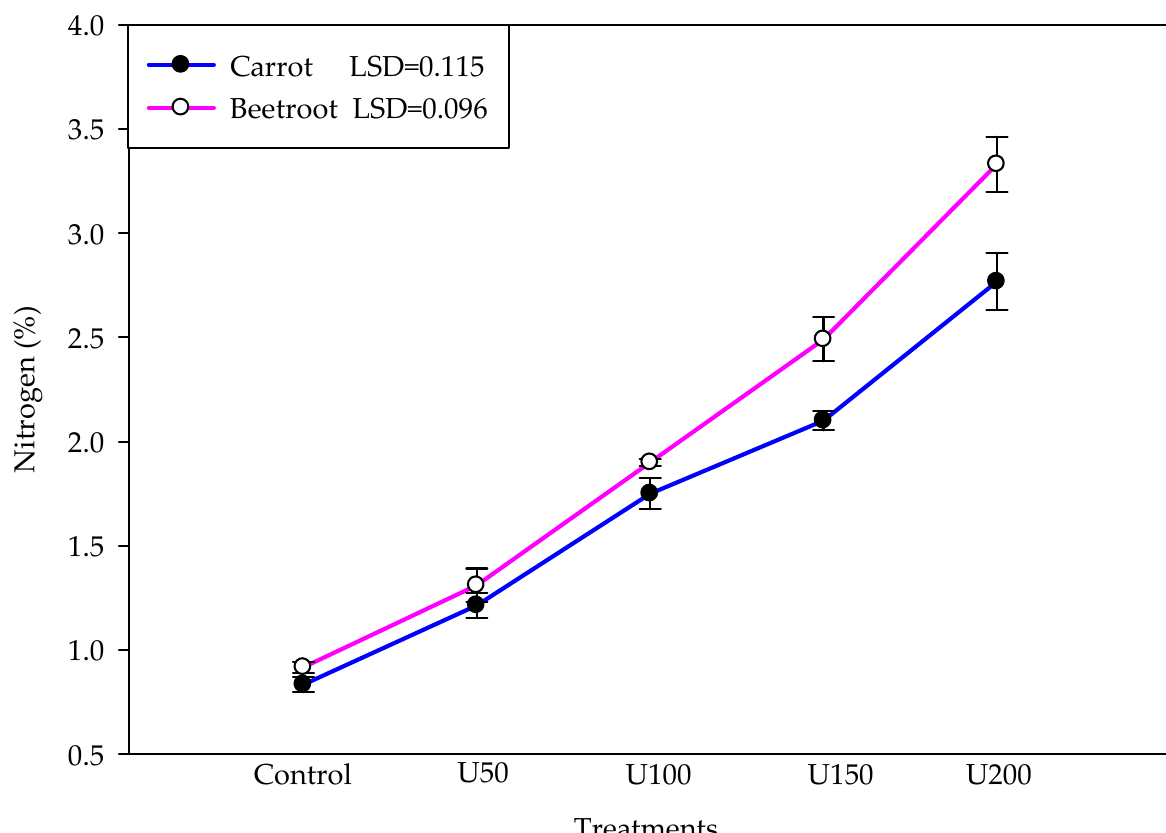
Figure 6. Impact of different N levels on the N uptake by carrot and beetroot. Data from experiments are collected as the mean of three replicates ± standard error (SE).